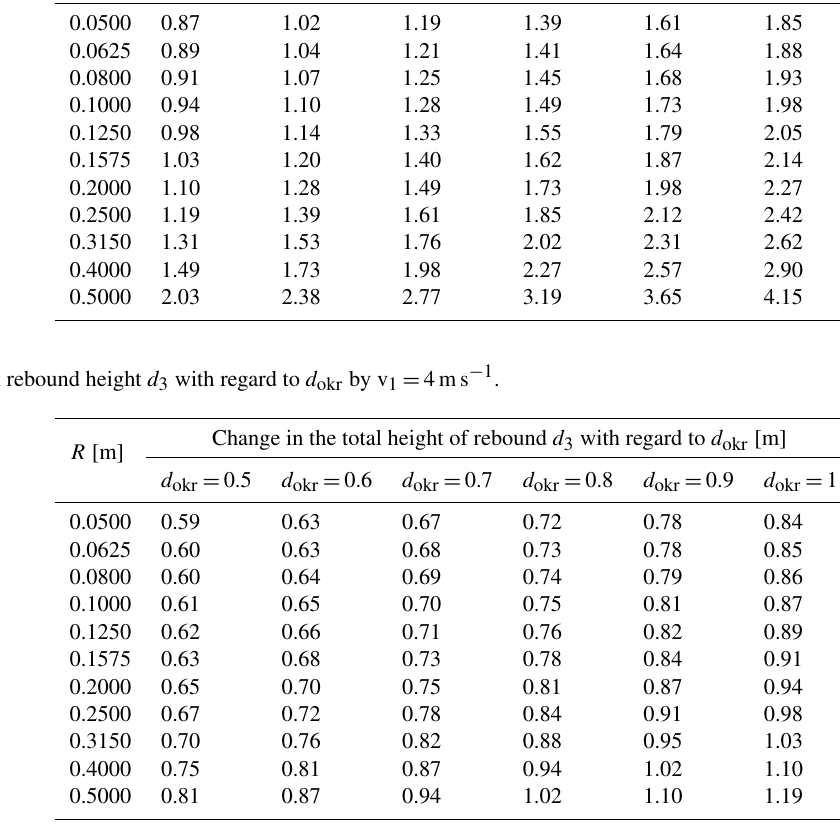
Table 4. Change in rebound height d 3 with regard to d okr by v 1 = 2ms − 1 . Change in the total height of rebound d 3 with regard to d okr [m] R [m] d okr = 0.5 d okr = 0.6 d okr = 0.7 d okr = 0.8 d okr = 0.9 d okr = 1